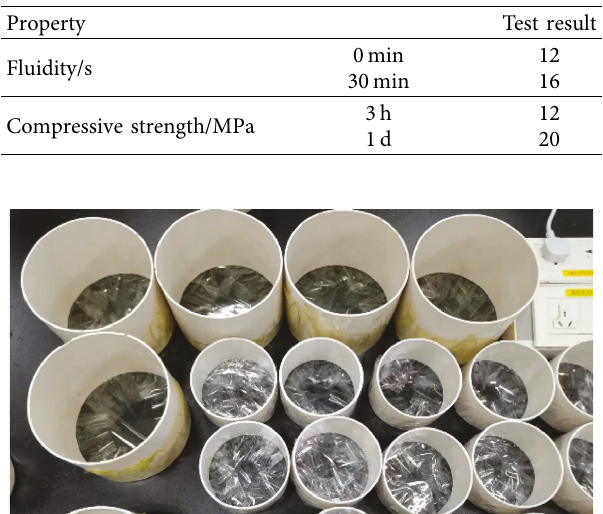
Table 3: Properties of grouting slurry.